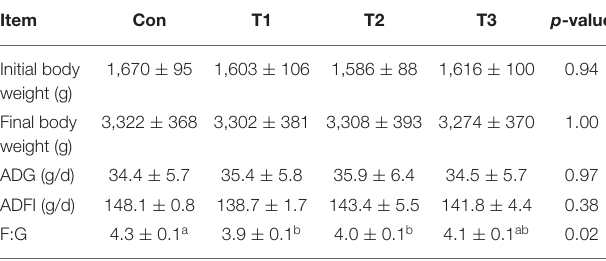
TABLE 2 | Effects of dietary supplementation with Elephantopus scaber on growth performance of ducks.